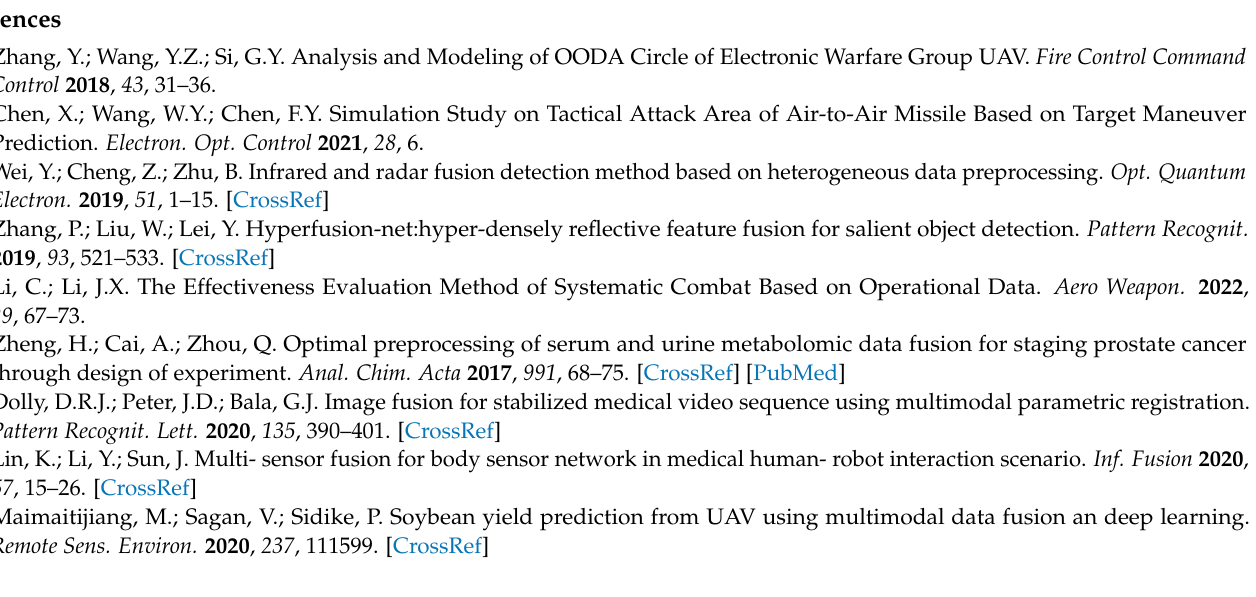
and 𝛿 (cid:3004) are the loss value used for back propagation. 𝛿 (cid:3035) where 𝛿 (cid:3035) (cid:3295) (cid:3295) diate quantity in the process and does not actually participate in the back propagation.